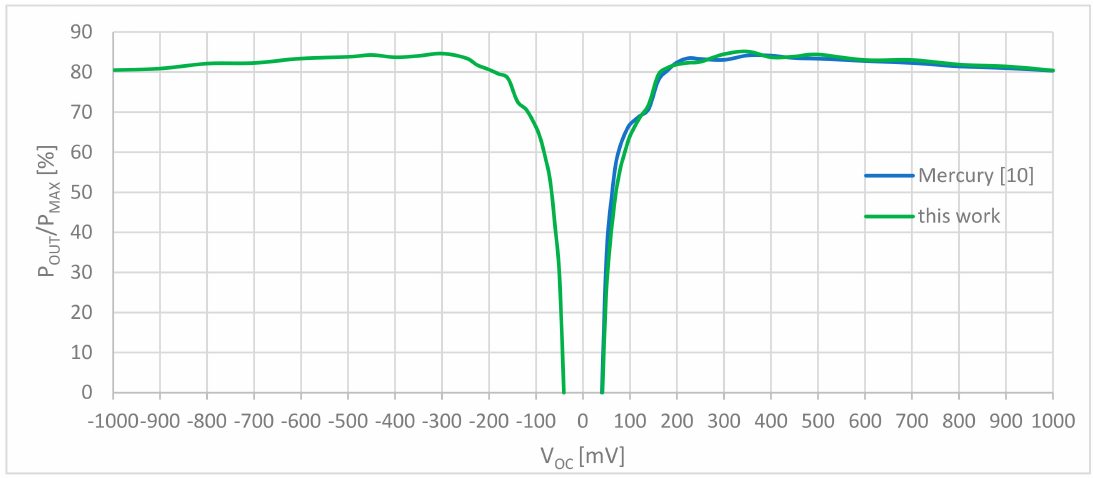
Figure 10. E ffi ciency vs. V OC for R TEG = 60 Ω and V OUT = 3.0 V.